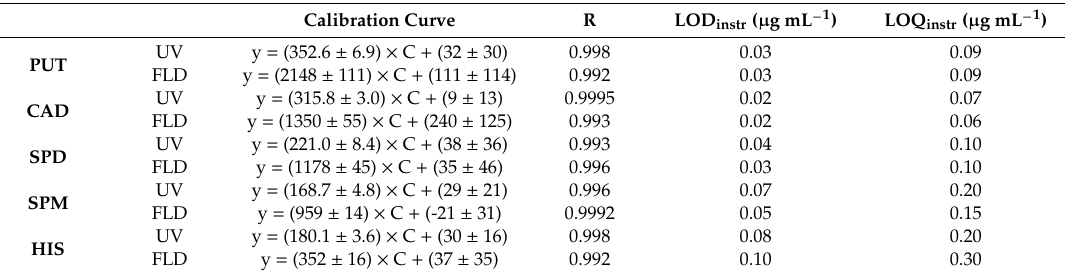
Table 3. Standard calibration curves, instrumental limit of detection (LOD instr ) and quantification (LOQ instr ) of the derivatized BAs with UV and Fluorescence detectors C: µ g mL − 1 . y: analyte peak area. Concentration range: 0.1–10 µ g mL − 1 .